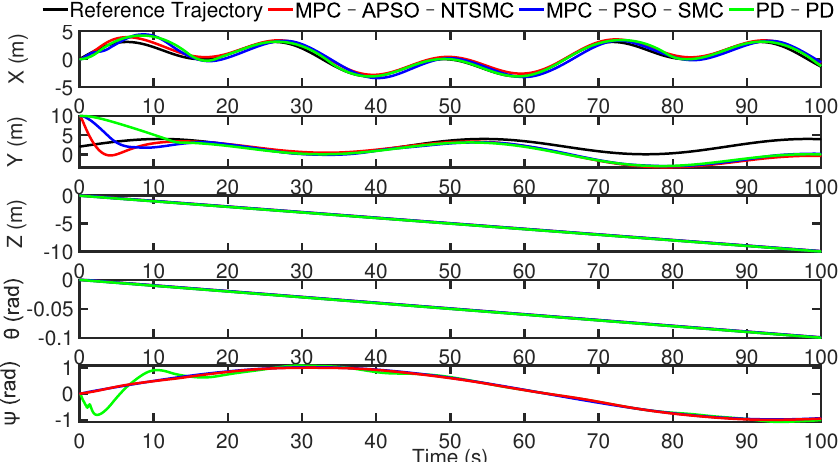
Figure 22. Position tracking performance for the tracking task without disturbance for Case 2.